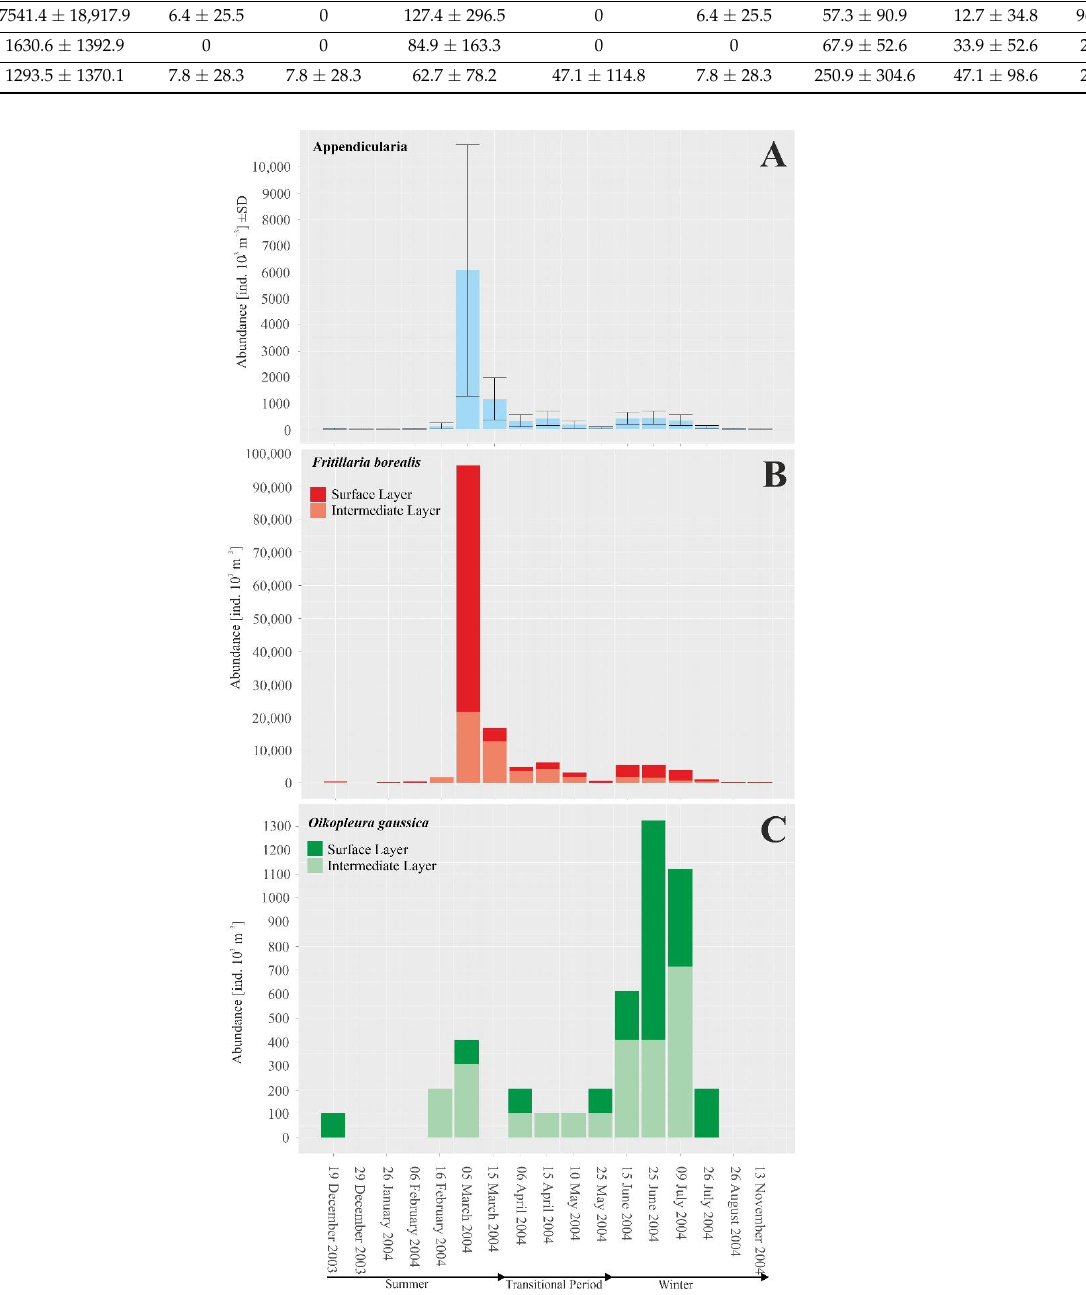
Figure 3. Monthly changes in abundances of Appendicularia in Admiralty Bay, December 2003–November 2004: ( A )—all recorded individuals and species (means ± SDs) (ind. 10 3 m − 3 ), ( B )— Fritillaria borealis , ( C )— Oikopleura gaussica